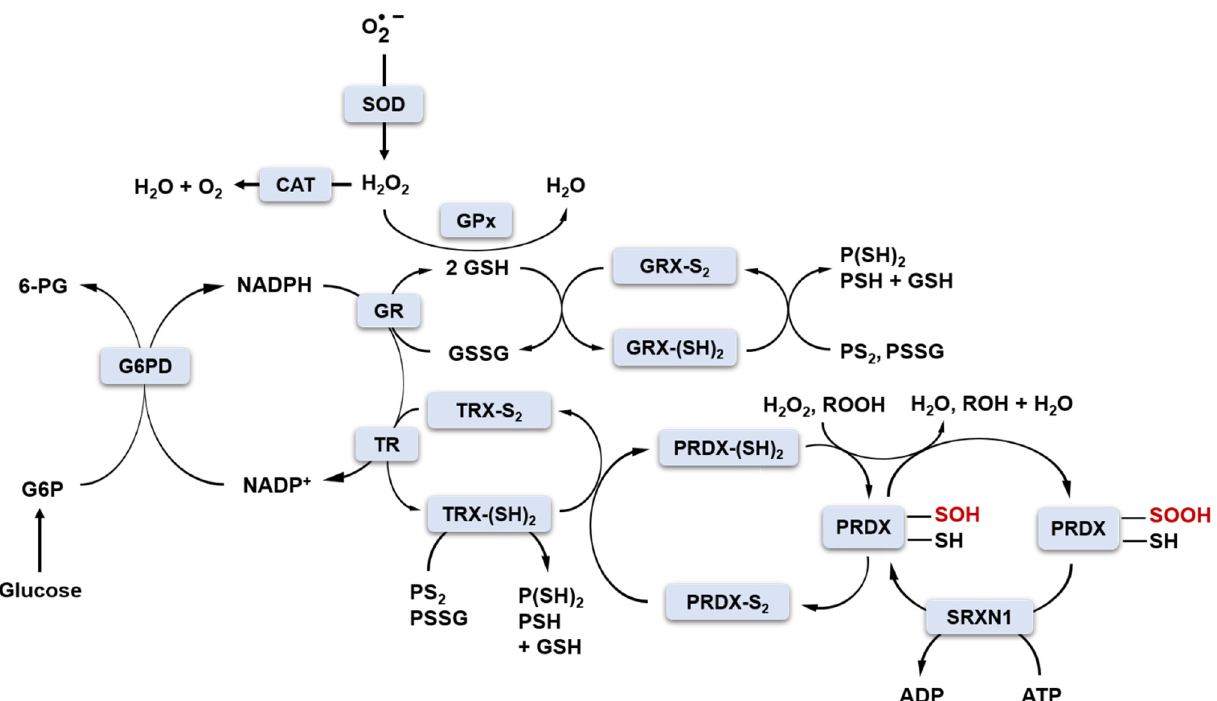
Figure 2. The balance between oxidants and antioxidants ensures cellular redox homeostasis.